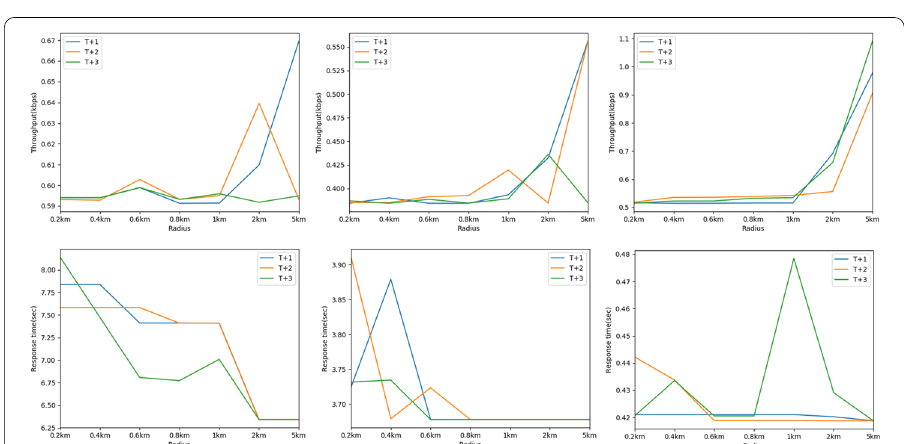
Fig. 7 The influence of the choice of neighbor radius on the user level